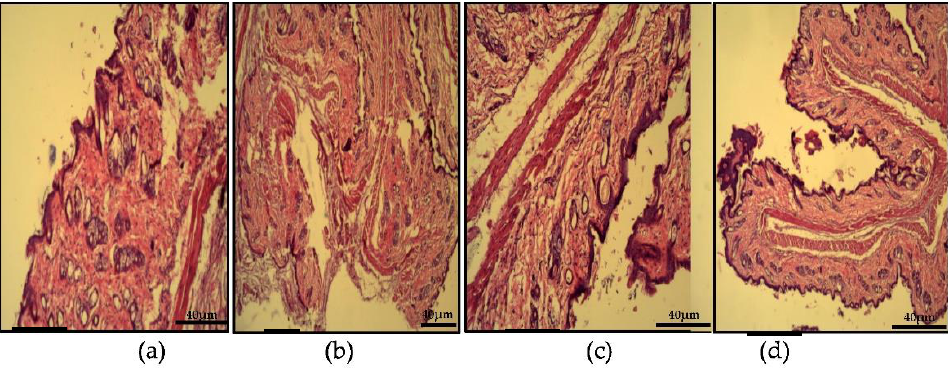
Figure 11. Histopathological analysis of ( a ) normal group, ( b ) negative group, ( c ) positive group, ( d ) treatment group.